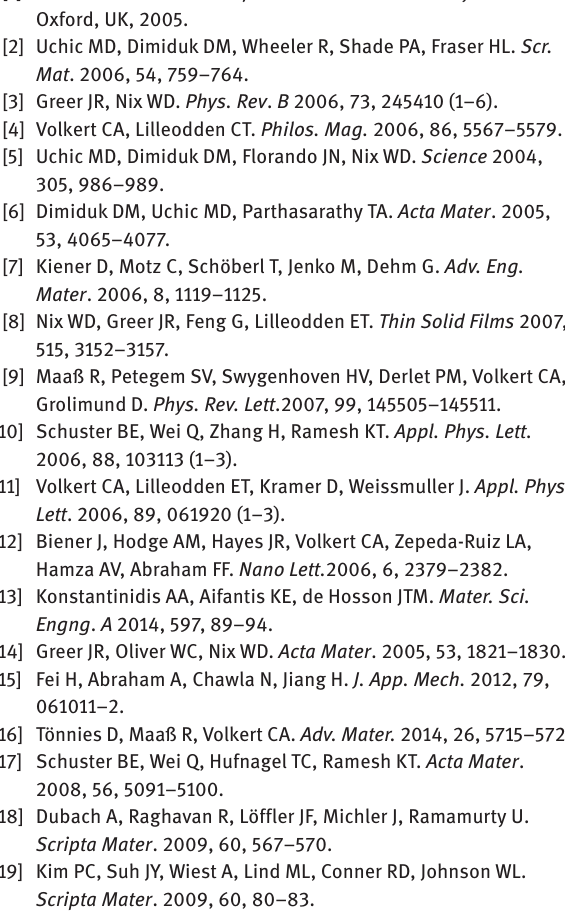
Figure 6: Engineering stress-strain graphs during Zr-based metallic glass micropillar compression [18]. The slope of the straight line provides a modulus value of 40–46 GPa.